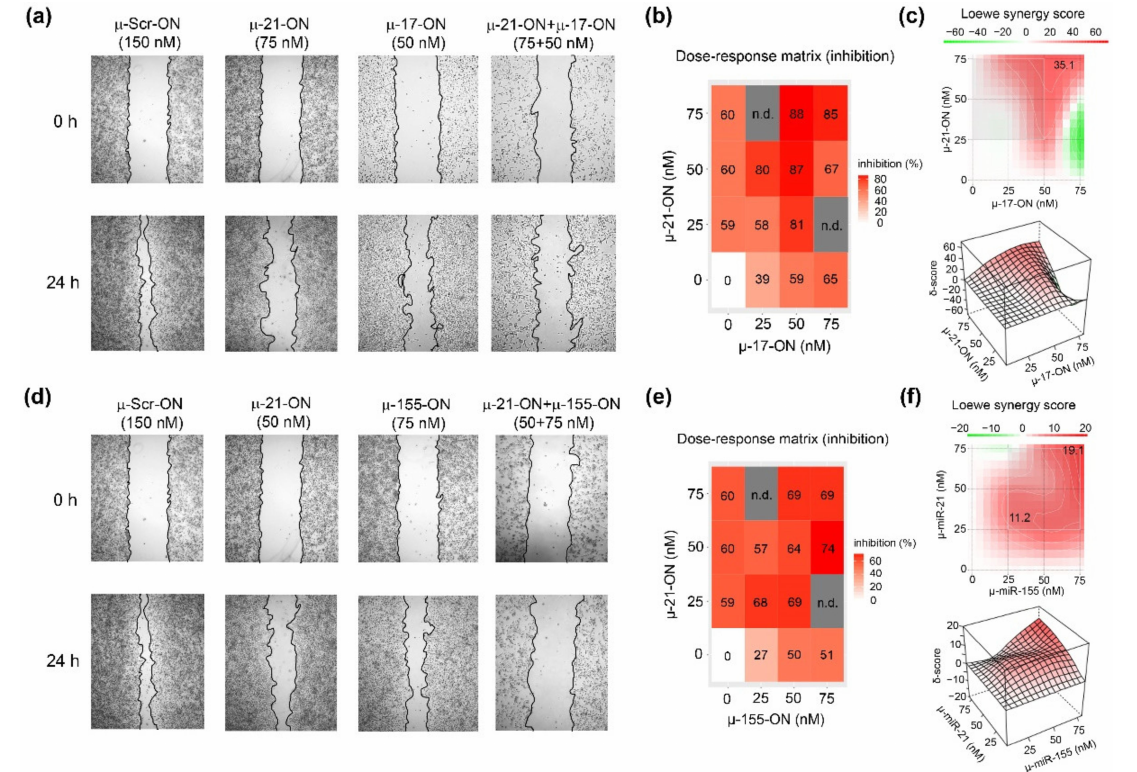
Figure 3. Antimigrative effect of oligonucleotide cocktails µ -21-ON/ µ -17-ON and µ -21-ON/ µ -155- ON on B16 melanoma cells. ( a , d ) Migration activity of B16 cells, determined by wound healing assay, 24 h after Lipofectamine™2000-mediated transfection with µ -21-ON, µ -17-ON and µ -155-ON used separately and in combinations of µ -21-ON/ µ -17-ON and µ -21-ON/ µ -155-ON. µ -Scr-ON–B16 cells treated with control oligonucleotide µ -Scr-ON (150 nM). Concentrations of µ -oligonucleotides are shown at the top. ( b , e ) Matrices demonstrating inhibition of cell migration by different concentra- tions of oligonucleotides in combinations of µ -21-ON/ µ -17-ON and µ -21-ON/ µ -155-ON. n.d.—not determined; ( c , f ) Loewe score showing synergistic/antagonistic effect of µ -21-ON/ µ -17-ON and µ -21-ON/ µ -155-ON pairs on cell migration. The heatmap shows the score values for the areas with the highest synergy. The data were analyzed using the SynergyFinder web application. The data were analyzed with the SynergyFinder software (https://synergyfinder.fimm.fi/, accessed on 14 February 2022). The synergy score < − 10—antagonism; − 10–10—additive effect;